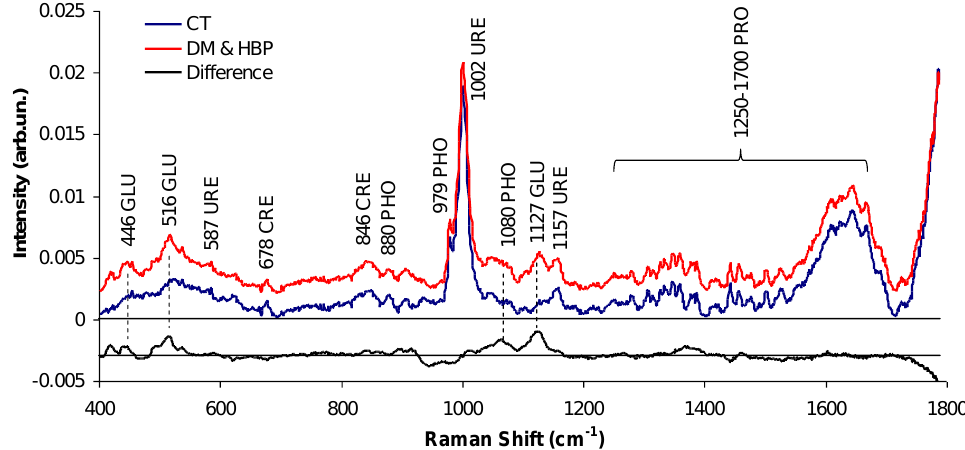
Figure 2. Mean Raman spectra of the CT and DM&HBP groups and difference spectrum (DM&HBP- CT). The assignments of the main peaks are detailed in the text. Spectra are offset for clarity. GLU: glucose; URE: urea; CRE: creatinine; PHO: phosphate; PRO: total protein.